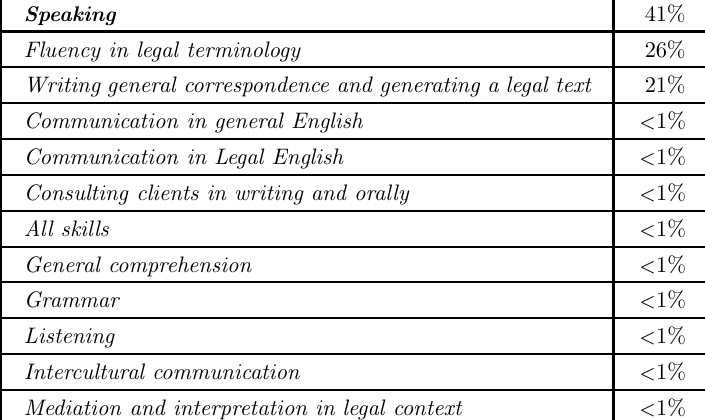
Skills of English most in need of improvement among participants Speaking 41%